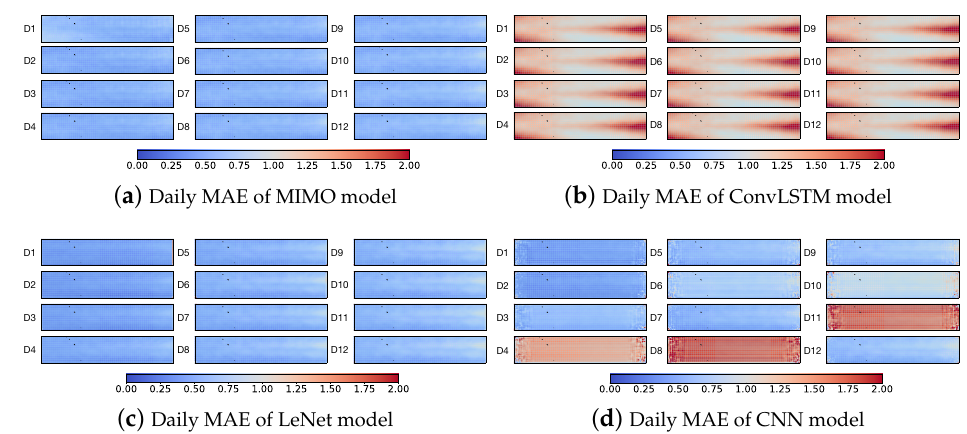
Figure 9. The results of daily SST prediction in Ni ˜ no 3.4 region.